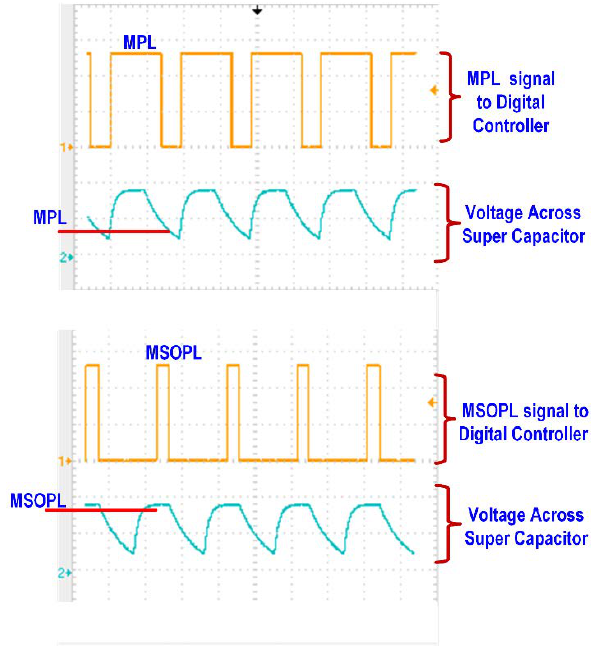
Figure 21. Charge and discharge voltage across the supercapacitor and MSOPL/MPL output signals.